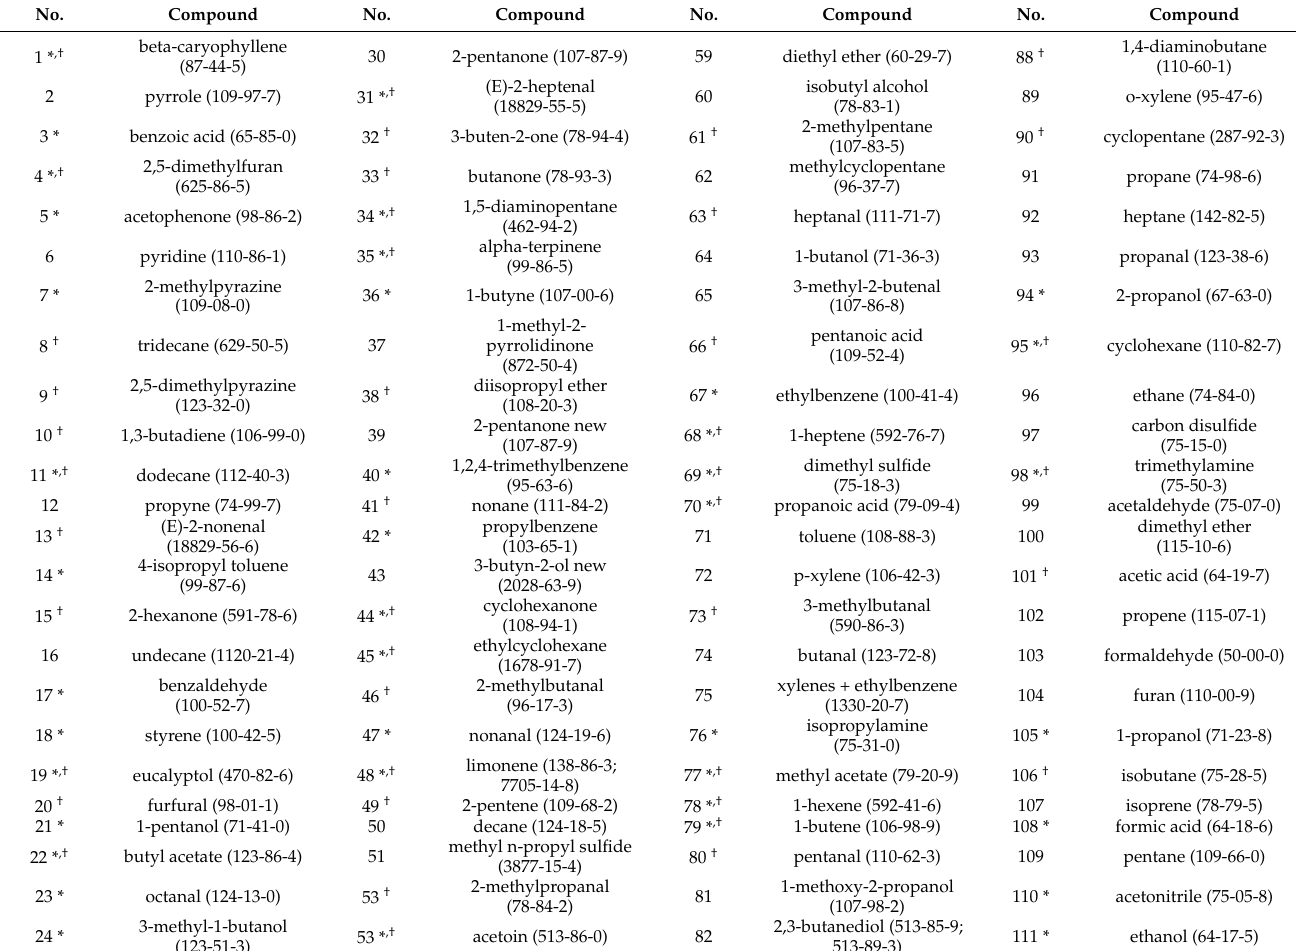
Table A1. The 116 VOCs selected for selected ion flow tube mass spectrometry analysis of breath samples in this